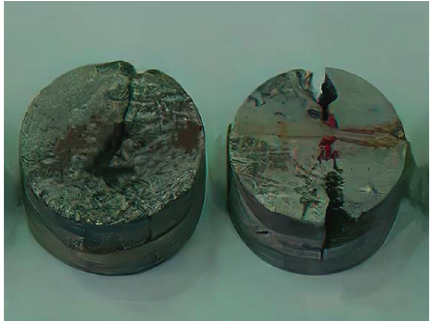
Figure 2: Rock failure under the Brazilian split